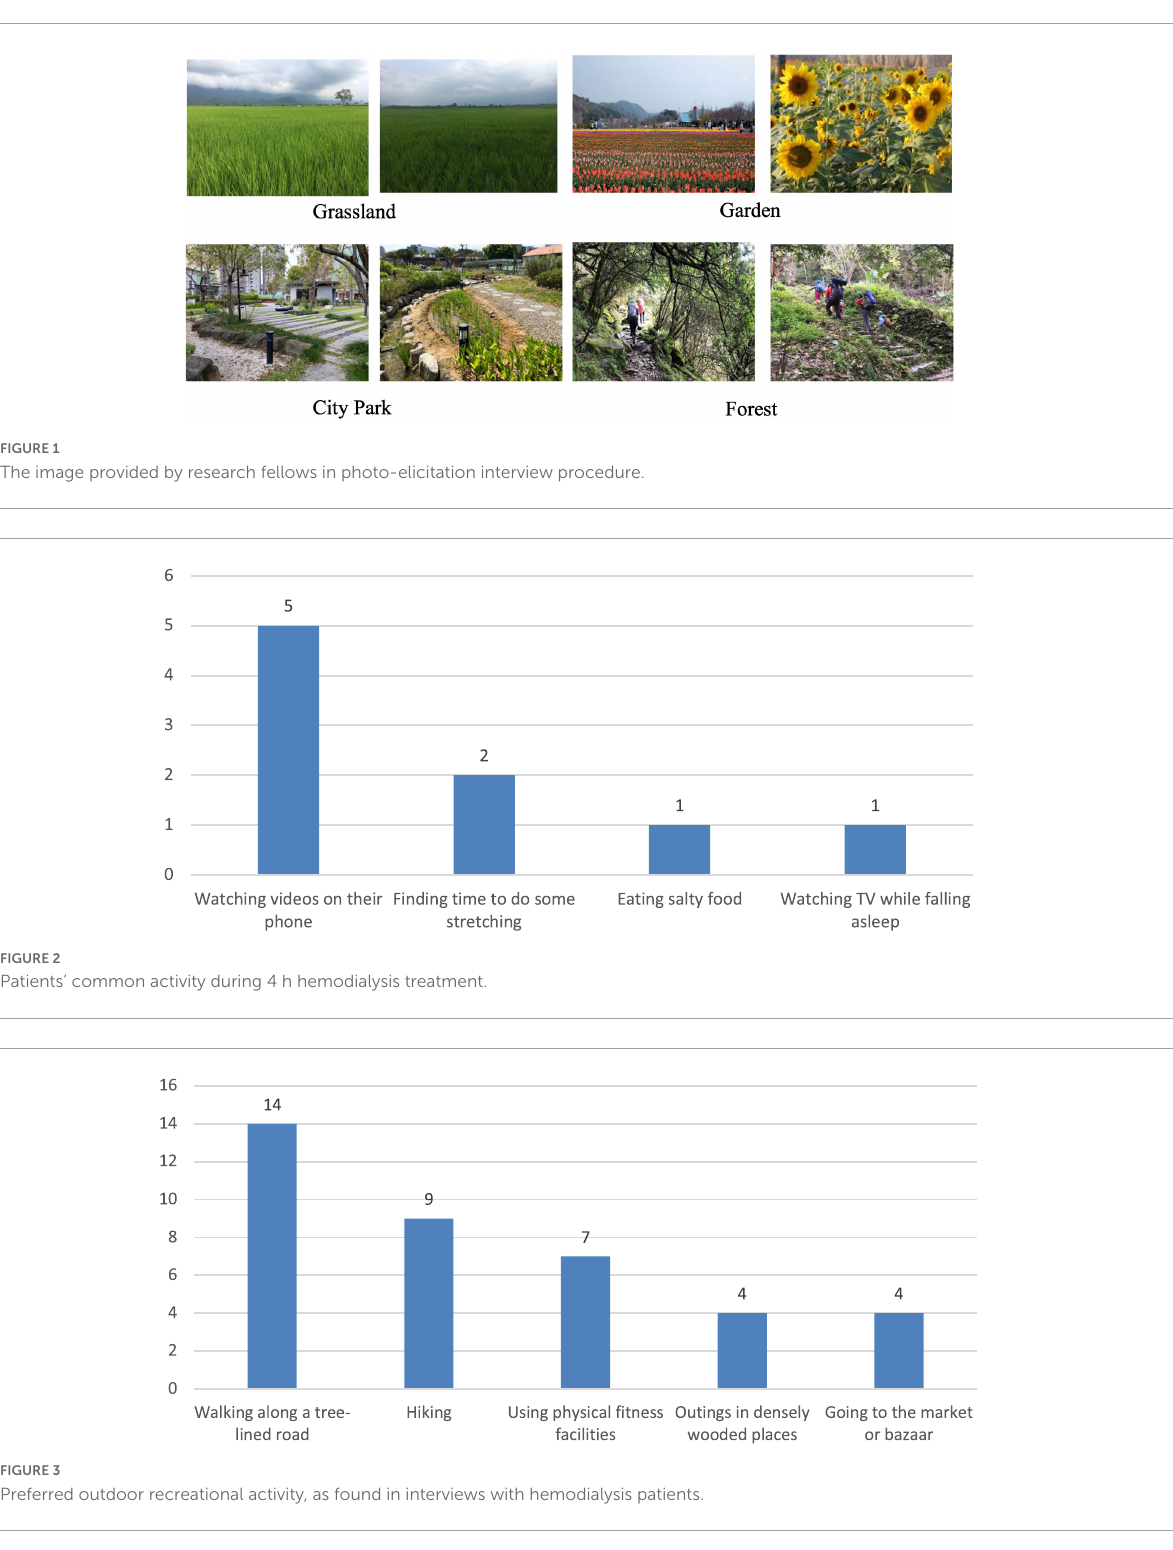
session consisted of six periods, corresponding to specific measurements or tasks (T0–T5, as illustrated in Figure 5 ). The experimental procedure above was conducted every week.